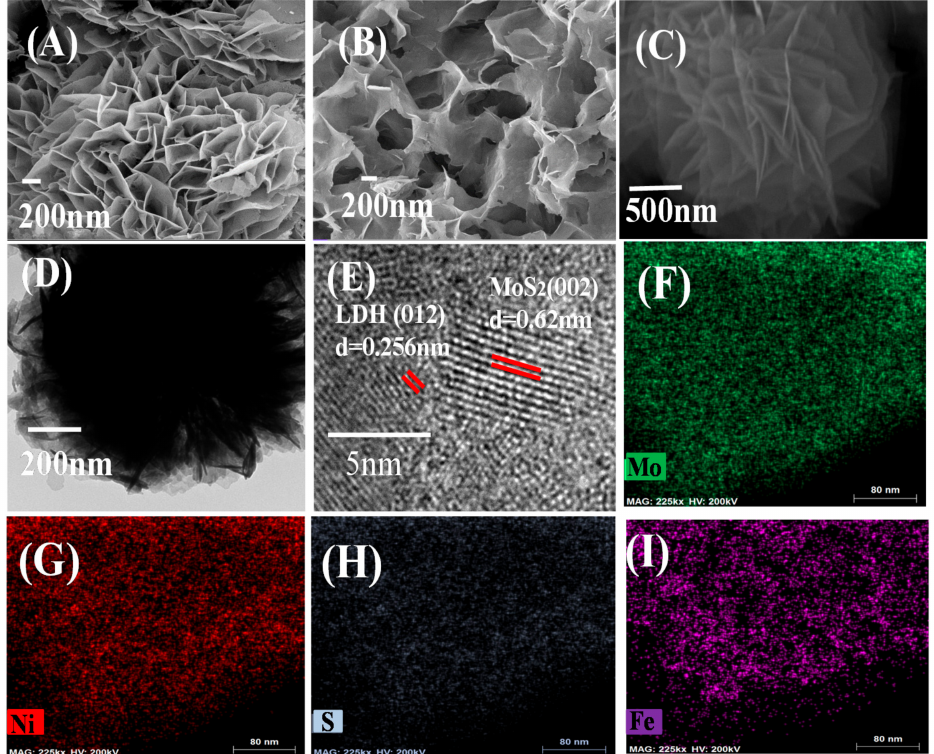
Figure 3. SEM images of LDH ( A ), MoS 2 ( B ) and MoS 2 /LDH-5% ( C ); HRTEM images ( D , E ); and STEM–EDX mapping images of MoS 2 /LDH-5% ( F – I ).